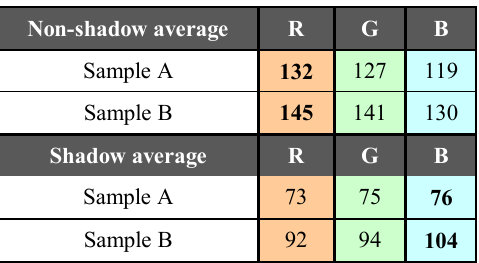
Table 3. Color Comparison (Average)